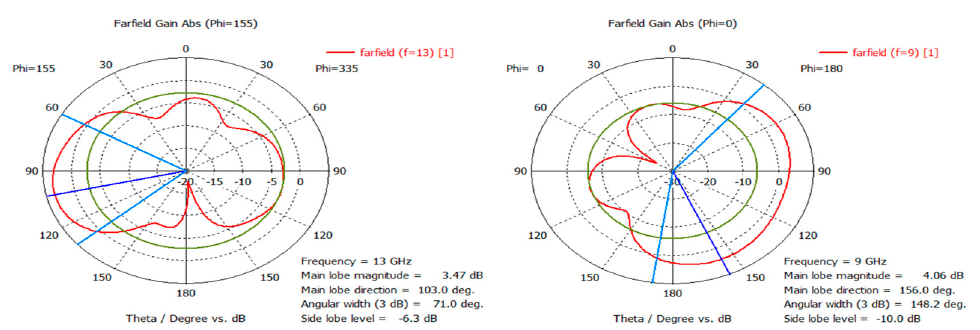
Figure 5. Surface current distribution.